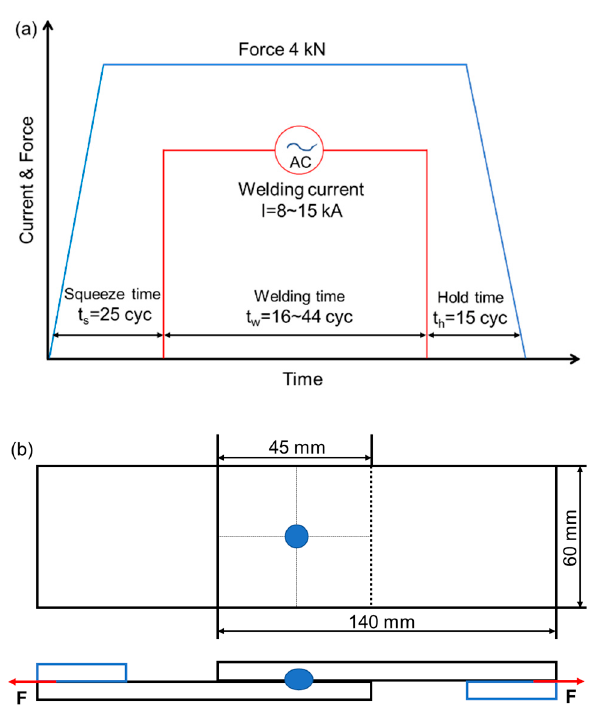
Figure 2. ( a ) Welding processes (1 cyc = 0.02 s); ( b ) Dimensions of the spot-welded samples.